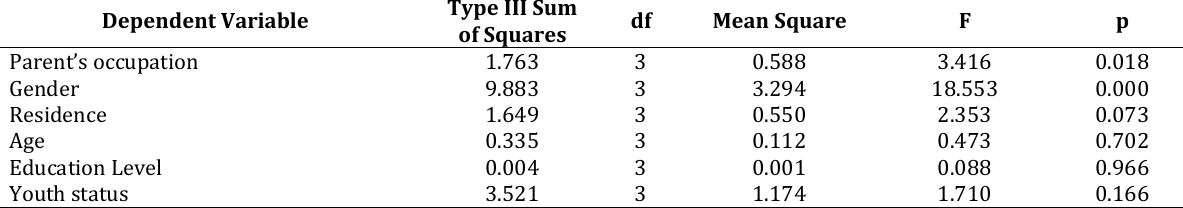
Table 3. Variables that are most closely related to bullying